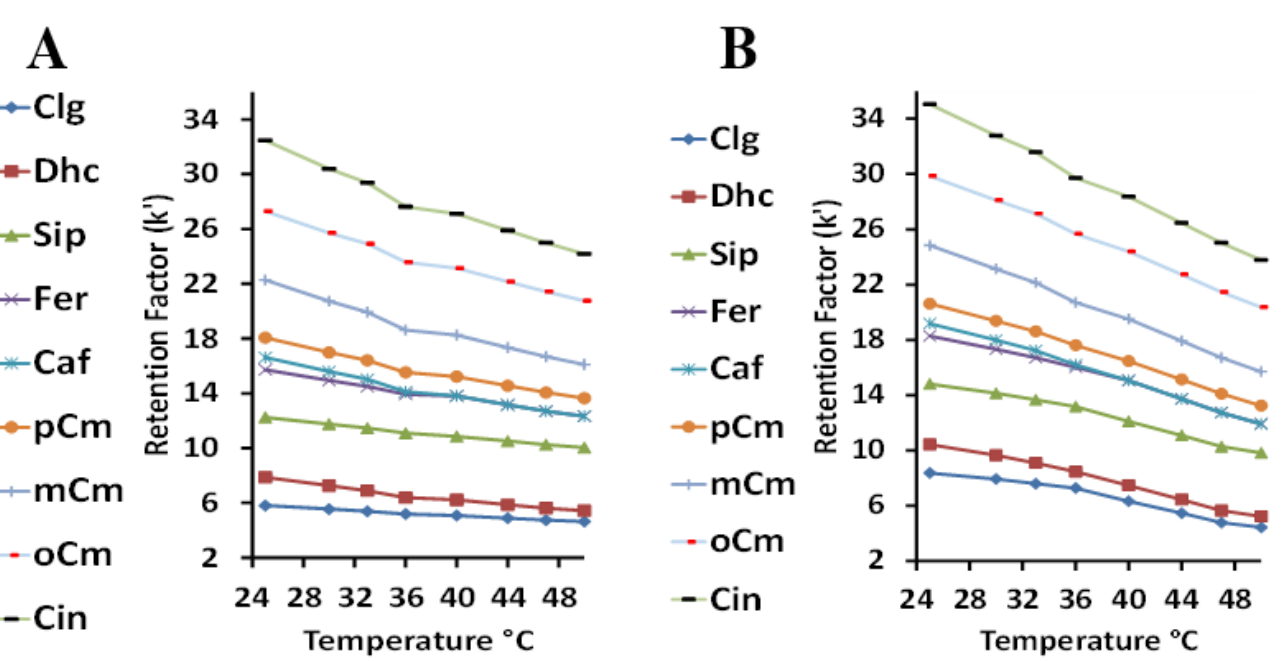
Figure 3. The relationship between the retention factor (k) and the temperature using Tween 20 ( A ) and Tween 40 ( B ).